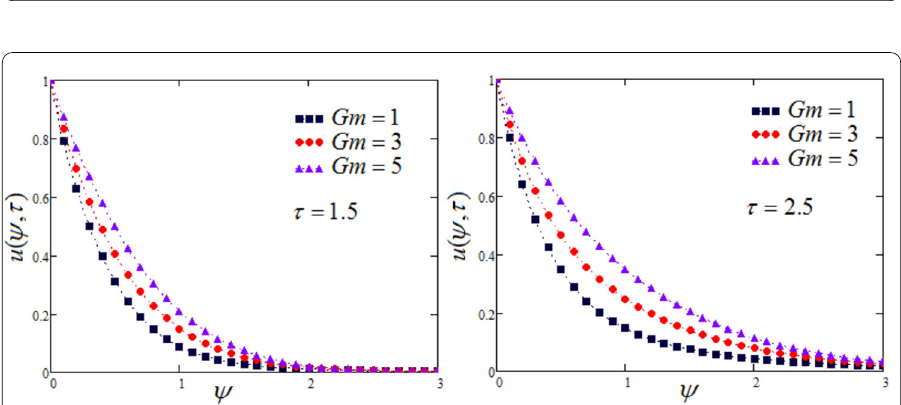
Figure 4 Concentration profiles of a Maxwell fluid for various values of Sc at two different times